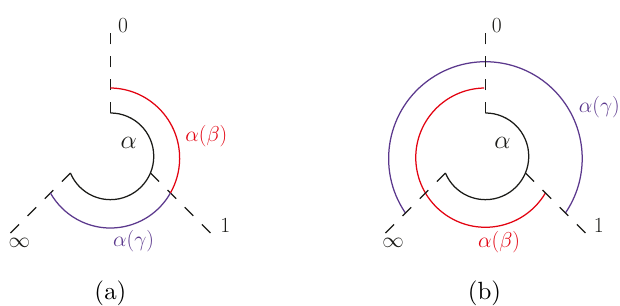
Figure 7 . The two possibilities for three way boundary matching. We plot the range of (cid:11) on a circle from [ ; ] passing through 0 and 1. Black is the range of (cid:11) in diagram D1, in red that of (cid:0)1 1 (cid:11) ( (cid:12) ) in D 2 and in blue the range of (cid:11) ( (cid:13) ) in D 3 . We see there is always a local pairwise matching of the three diagrams in both cases. In Case 1 D2 and D3 each only overlap with D1 and not with each other. For Case 2 all diagrams overlap the other